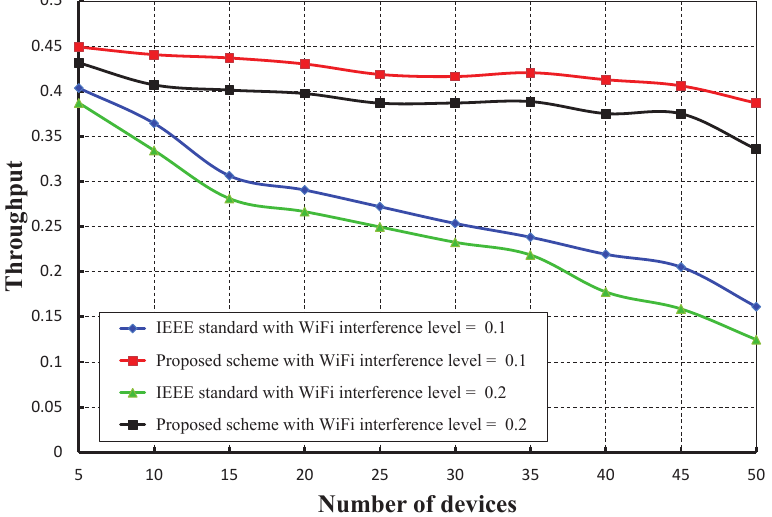
Figure 24. Comparison of the throughput of our proposed scheme with the IEEE 802.15.4e standard under different WiFi interference